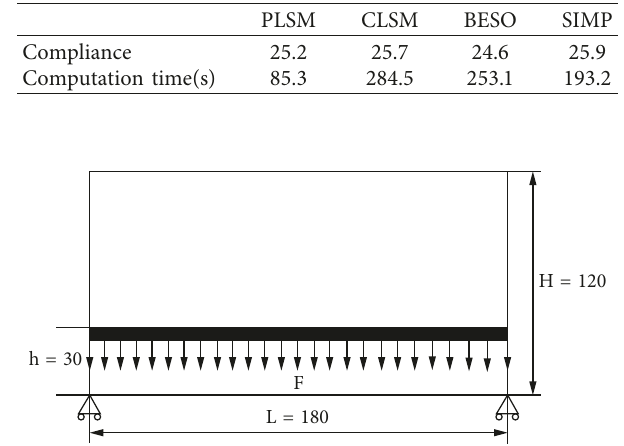
Figure 6: Design space of the half-through arch bridge.